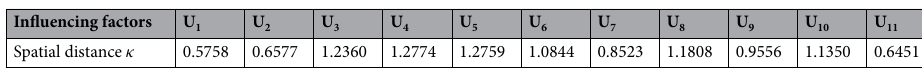
Table 5. Spatial distance of each